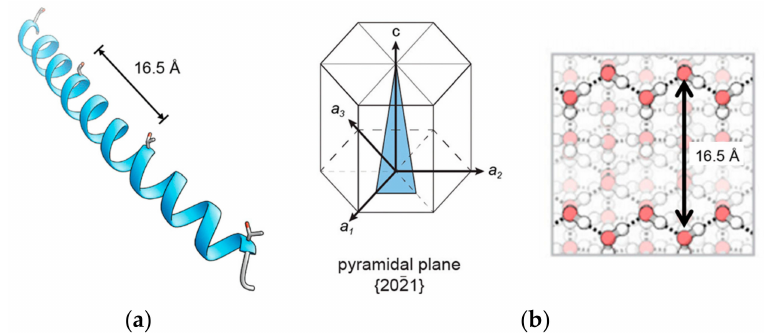
Figure 1. ( a ) Type I wf AFP from winter flounder (PDB:1WFA). The distance between threonine residues in wf AFP is 16.5 Å; ( b ) Representation of a pyramidal plane and the molecules that interact with the ice-binding site of wf AFP in a hexagonal ice crystal lattice with four lattice vectors indicated: the prism axis, c, which is normal to the basal plane, and the three vectors a 1 , a 2 , and a 3 , through alternate hexagonal points. Reprinted with permission from Proc. Natl. Acad. Sci. USA 2016 , 113 , 3740–3745. Copyright (2016) National Academy of Sciences [22].